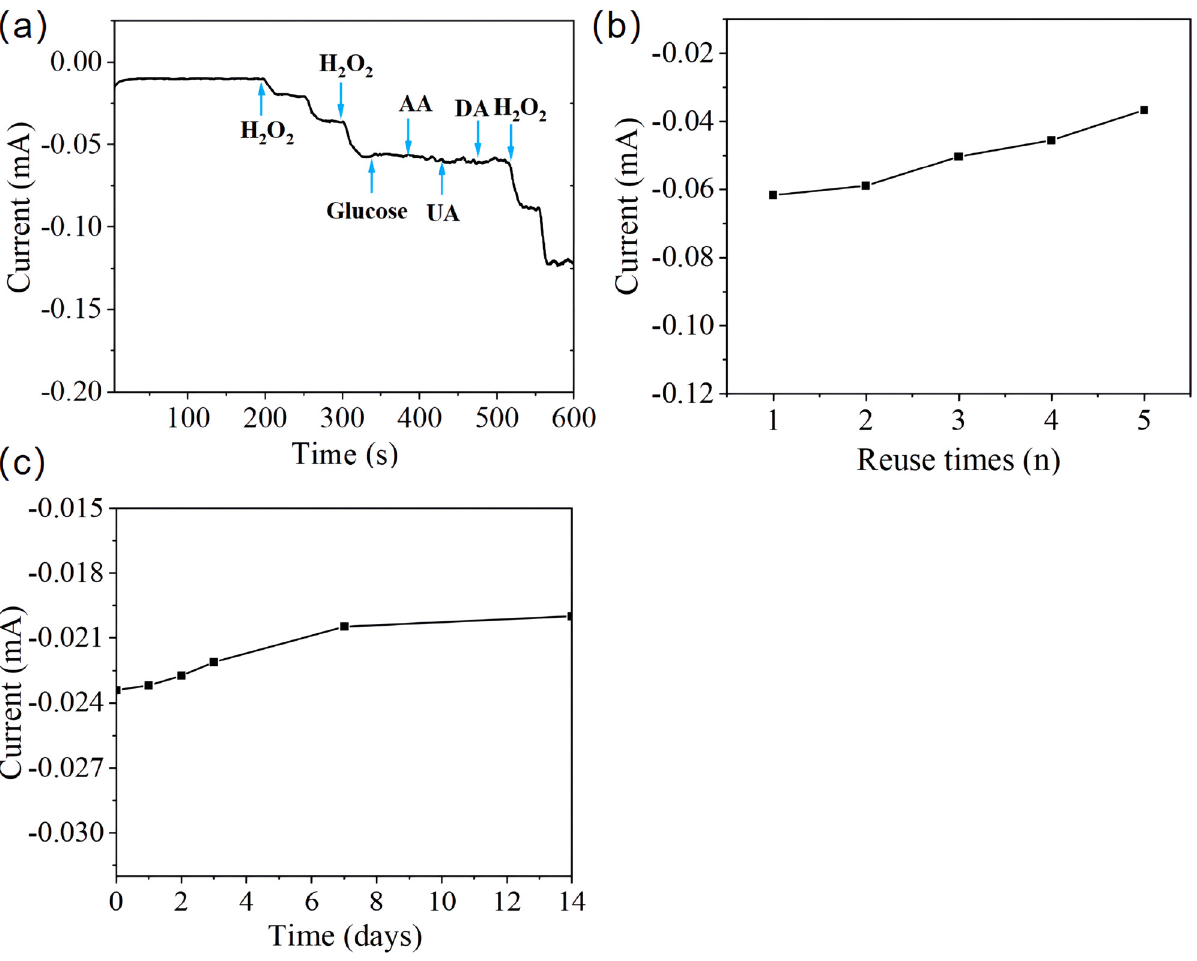
Figure 7: Performance of the H 2 O 2 sensor based on the Cu 2 O/Ag - rGO nanocomposites: ( a ) anti - interference capability, ( b ) reuse stability, and ( c ) long - term